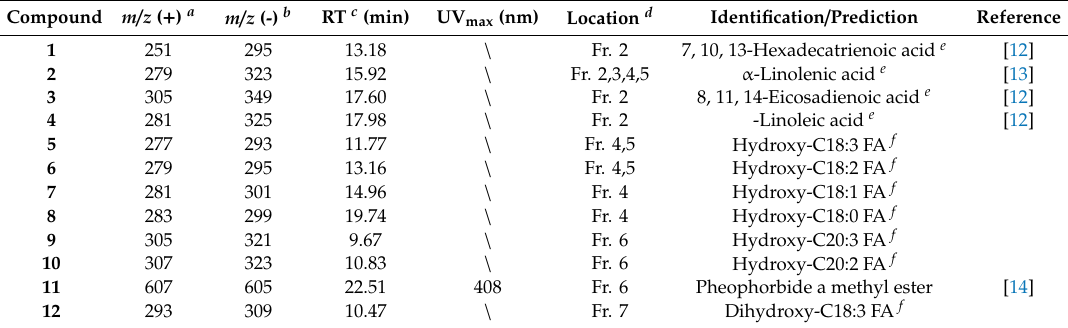
Table 1. Compounds 1 – 42 detected by UHPLC-qMS-UV in column